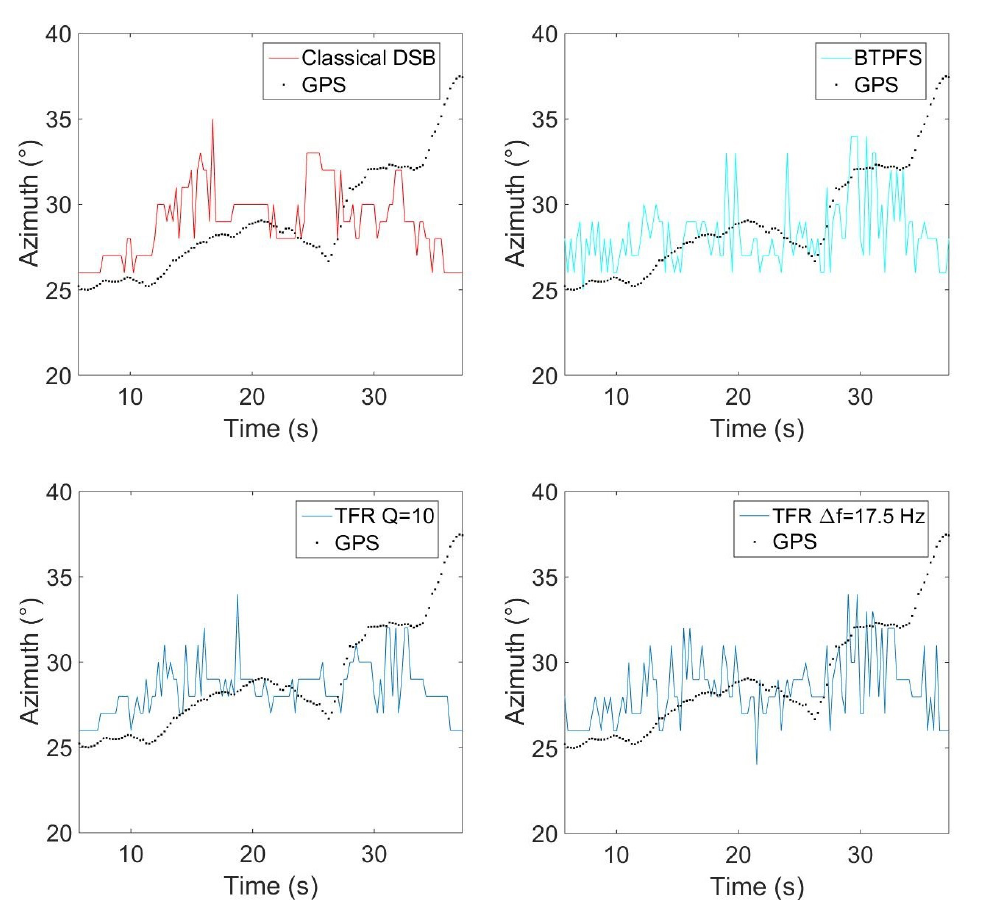
Figure 15. Evolution of the azimuth with time for the experimental trajectory, for the two types of bandwidth, with Q =